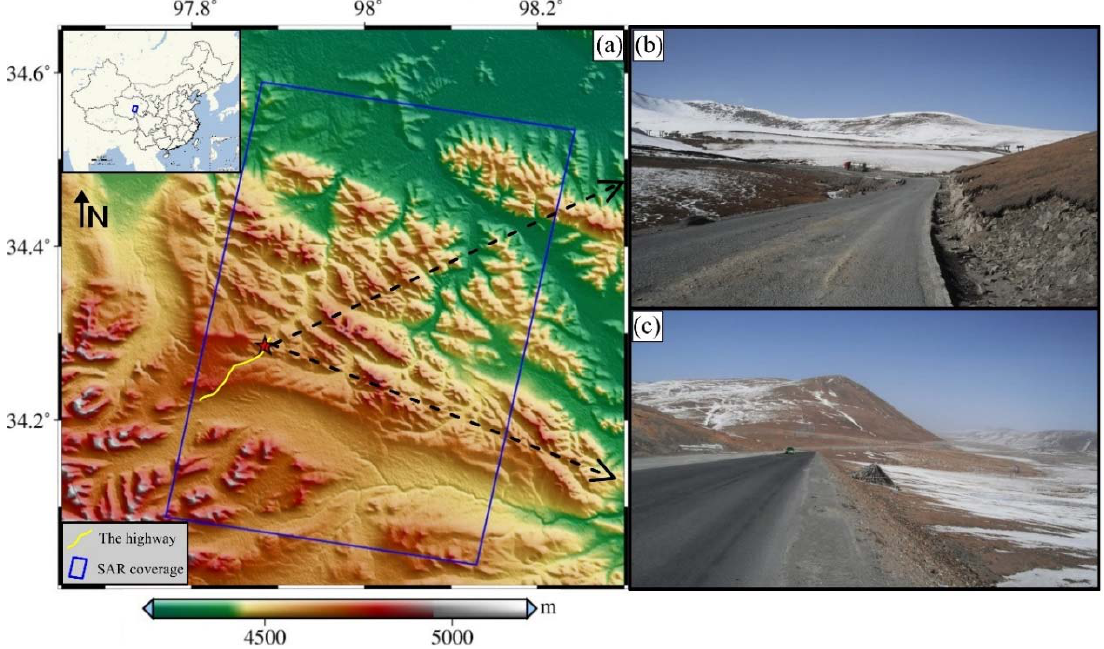
Figure 1. ( a ) The location of study area in China, the highway and the coverage of SAR image; ( b , c ) photos on site.